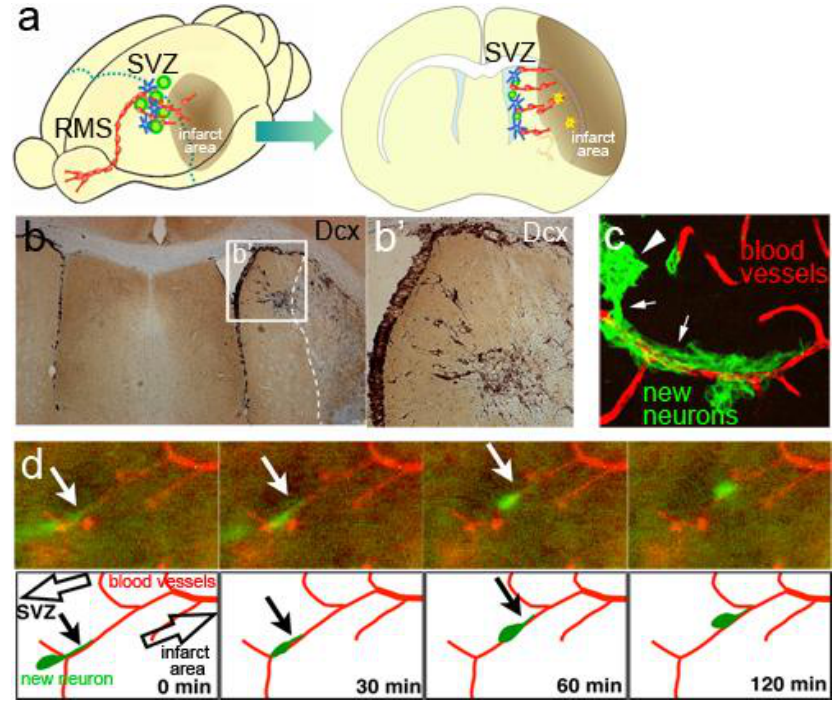
Figure 5. Migration of new neurons to an injured area. ( a ) Schematic drawings of SVZ new neurons migrating toward an infarcted area; ( b ) Mouse brain section 18 days after experimental ischemic stroke stained with the new neuron marker Dcx (brown). Transient middle cerebral artery occlusion (MCAO) caused infarction (white broken line). Eighteen days later, new neurons generated in the SVZ migrated toward the infarcted area. b’ shows a higher-magnification image of the boxed area in b; ( c ) Association of migrating new neurons with the vasculature. A brain section 18 days after MCAO was immunostained with Dcx (green) and the endothelial marker CD31 (red). Many of the new neurons migrating toward the infarcted area were closely associated with blood vessels; ( d ) Vascular scaffold for new neurons migrating toward the infarcted area. Time-lapse imaging of a cultured brain slice after MCAO. New neurons were labeled by lentivirus injection into the lateral ventricle of Flk1-EGFP mice. A new neuron (green) extended leading process (arrows) and migrated along a blood vessel